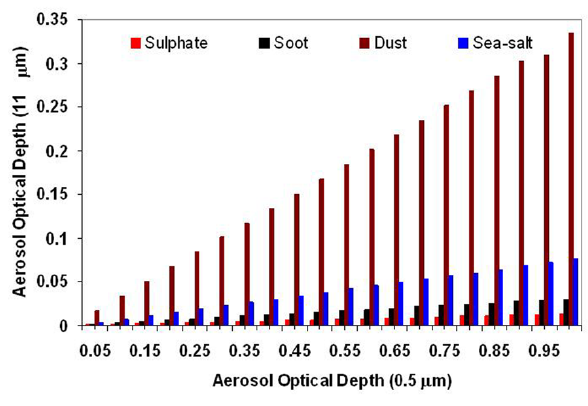
Fig. 1. Influence of various types of aerosols to infrared radiation, demonstrating that dust aerosols are the most sensitive to